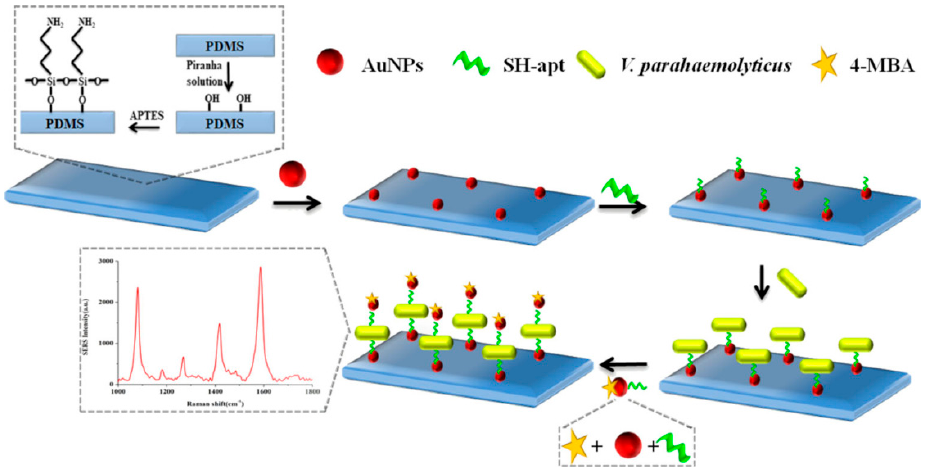
Figure 5. Schematic of SERS aptasensor based on Apt-Au-PDMS composites film for Vibrio parahaemolyticus determination. (Reprinted with permission from Springer, 2018 [65]).